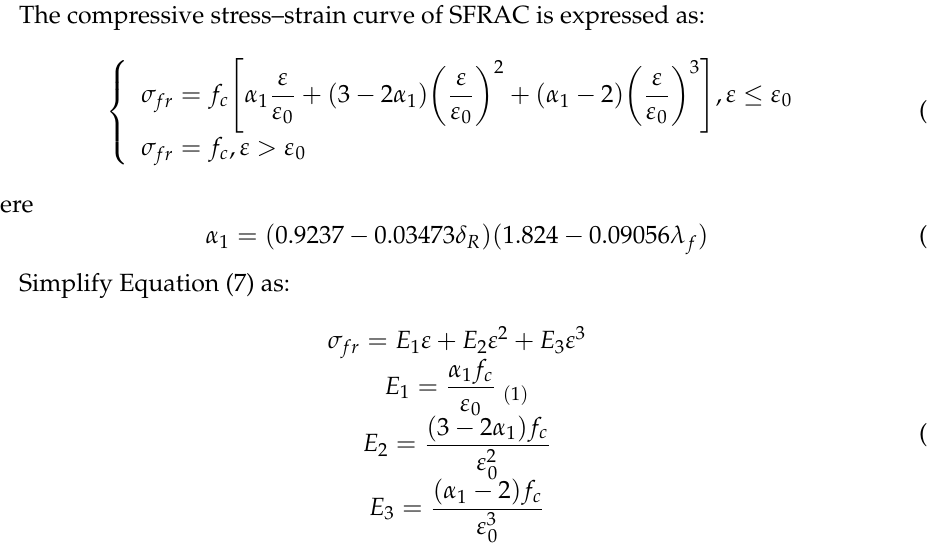
Figure 13. Stress and strain distributions of the strengthened beams under flexural failure.